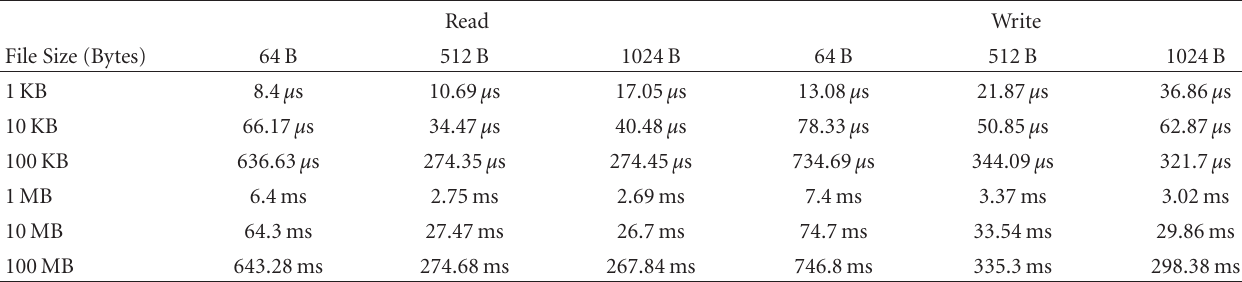
Table 6: Hardware filesystem read/write execution time with two RAM disk synthesized for the XC4VFX60. Read Write